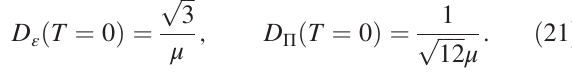
FIG. 4. Numerical results for the frequencies of the hydro- dynamic and longest-lived infrared modes of the neutral, trans- lation-symmetry breaking model at T=m ¼ 10 − 3 (circles). Away from ω , the analytic dispersion relation (11) (solid red line) n ≥ 0 provides an excellent approximation to the exact location of a pole.